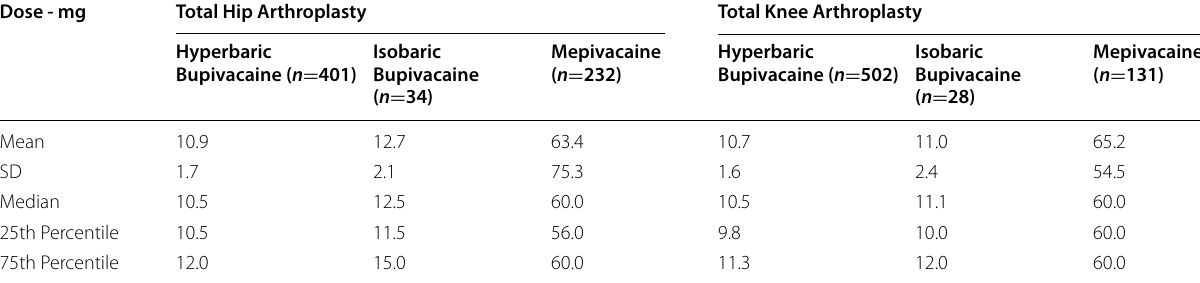
Table 2 Spinal anesthetic dosing Dose - mg Total Hip Arthroplasty Total Knee